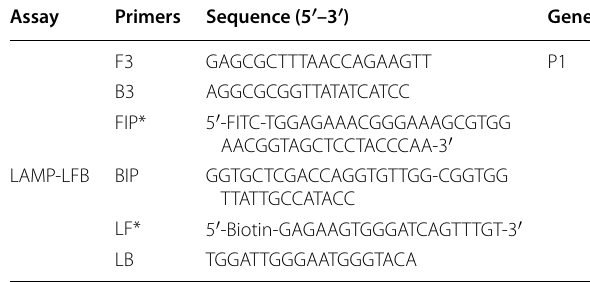
Table 2 Primers used in this